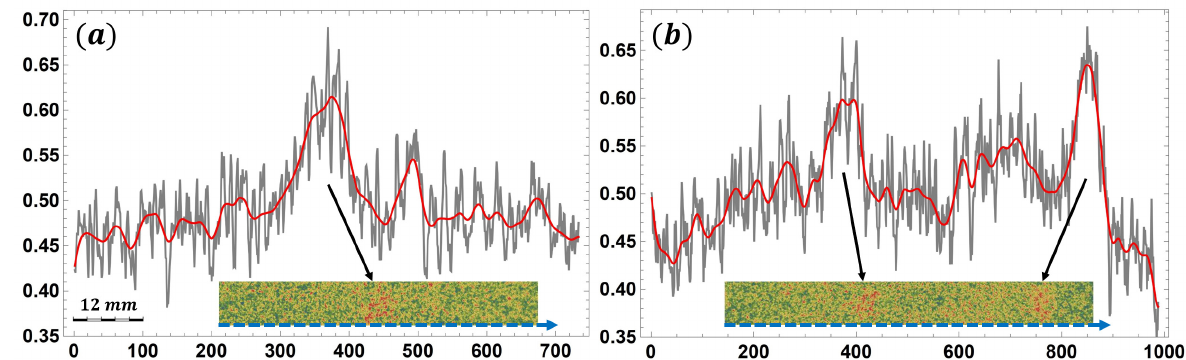
Figure 3. Bubble signal analysis for the cropped FOV: width mean of luminance (gray) over the length of ( a ) horizontal and ( b ) vertical patches roughly fitted to the bubble dimensions, spanning the FOV. Note the scale bar in ( a